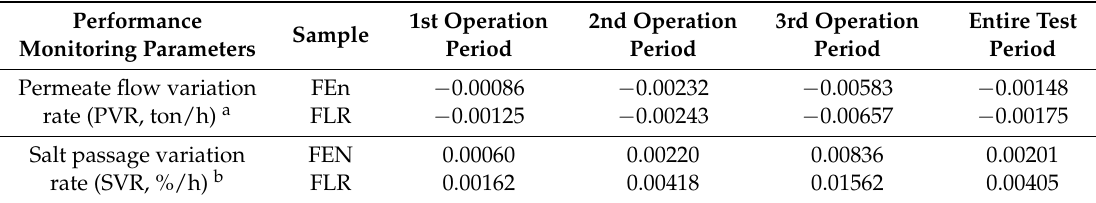
Table 6. Permeate flow variation rate (PVR) and salt passage variation rate (SVR) of both membranes according to the segmented operation